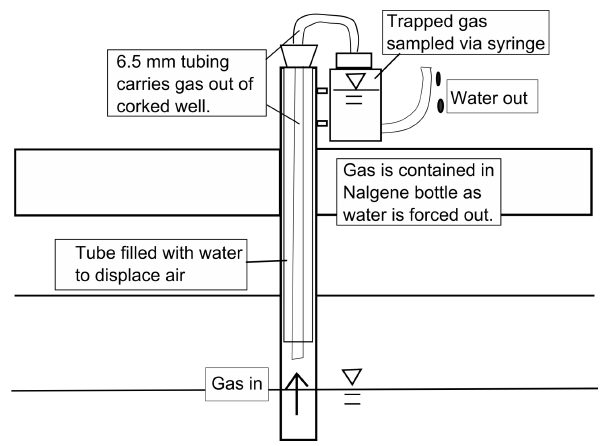
3 Fig. 3. Gas trap installed at one location to conclude if wells were